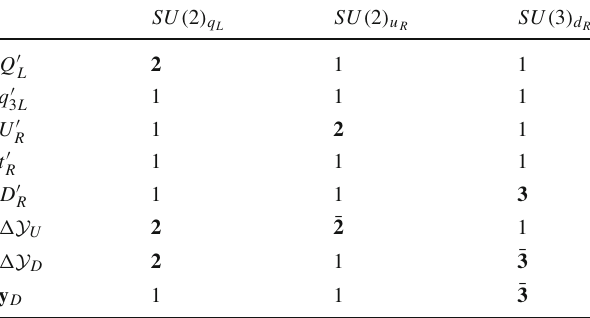
Table 1 Transformation properties of quarks and quark spurions under